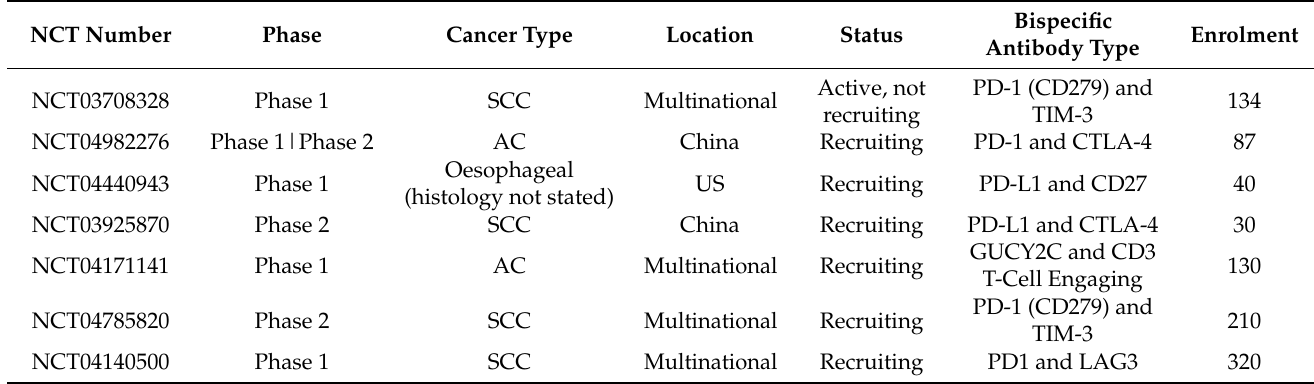
Table 2. Bispecific antibody clinical trials currently listed on clinicaltrials.gov, accessed on 25 May 2022. All trials are on patients with advanced or metastatic